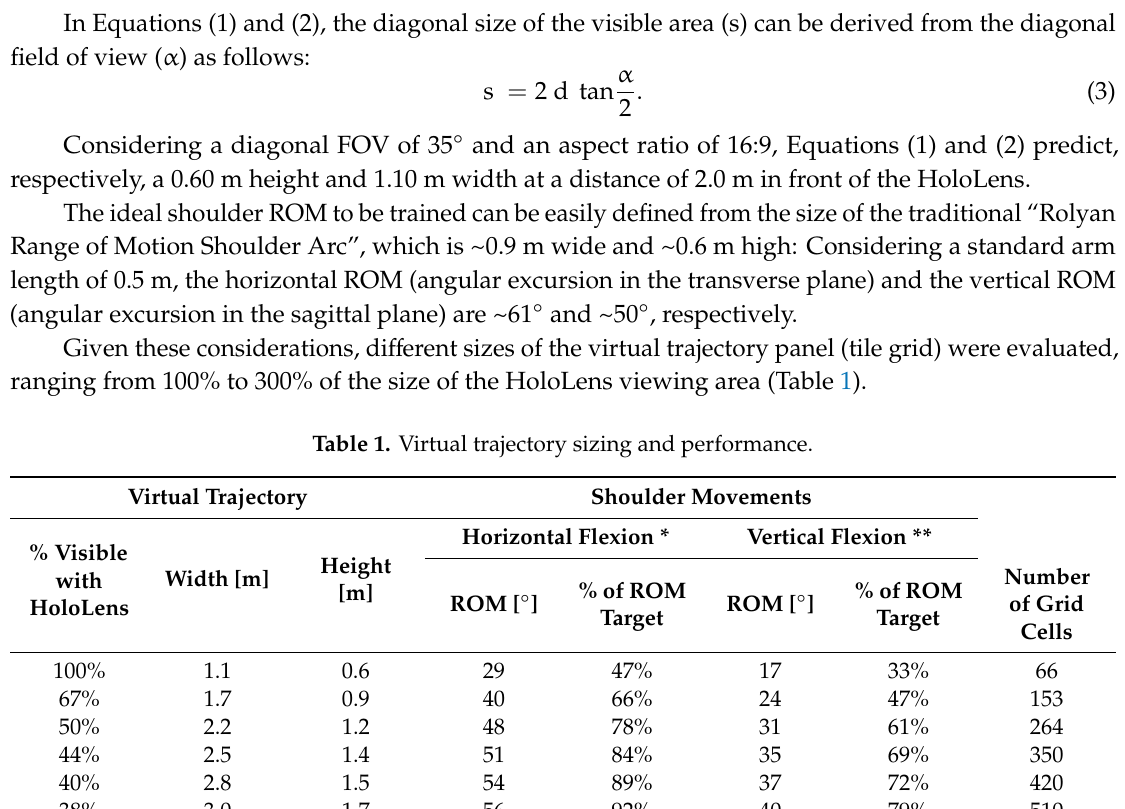
Table 1. Virtual trajectory sizing and performance.